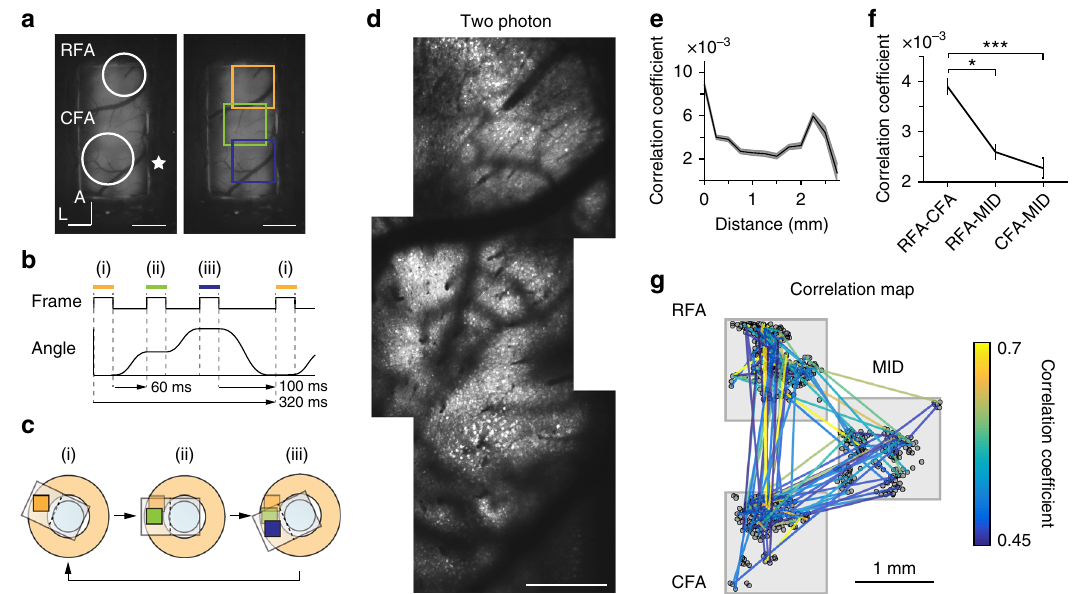
Fig. 5 Stitch imaging of mouse motor cortex. a An epi fl uorescence image of left R-CaMP1.07-expressing motor cortex. The three squares indicate the imaging fi elds (orange, RFA; green, the intermediate region (MID); blue, CFA) in d . Scale bar, 1 mm. b Timing chart of the stitch imaging of the three fi elds. c Schematic illustration of stitch imaging. d Averaged two-photon images of the three areas shown in a . Scale bar, 500 µ m. e Pairwise activity correlation as a function of the distance between the two neurons (see more details in Methods). Data were grouped into 250 µ m bins. The black line represents the mean and the gray shading represents s.e.m. f Mean inter-areal correlations between pairs of neurons from RFA, CFA, and MID. RFA, MID, and CFA